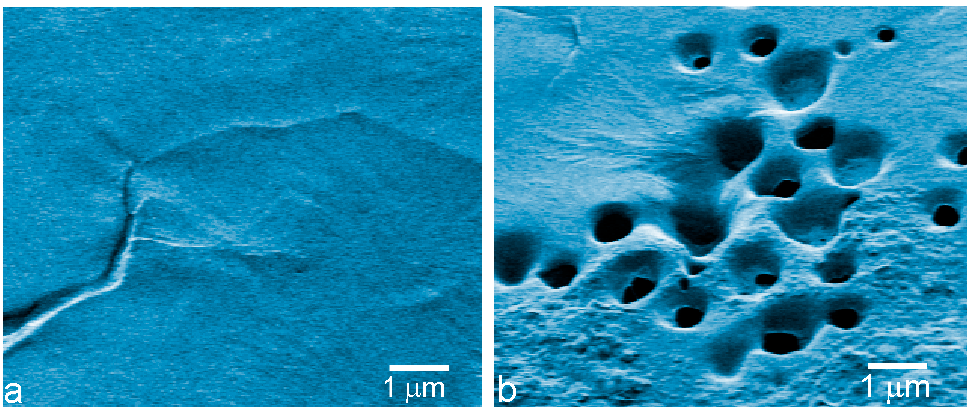
Figure 2 Figure 2. SEM images of the surfaces of PCL ( a ) and MnO release medium supplemented with glucose for 24